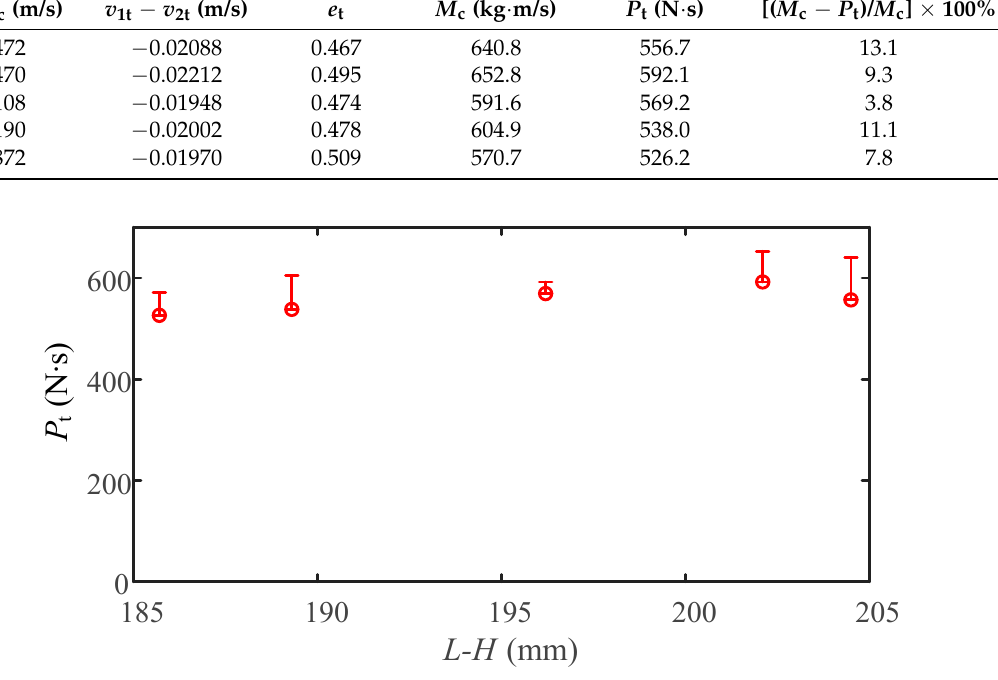
Figure 8. The error bars of the impulse P t and its theoretical value M c .